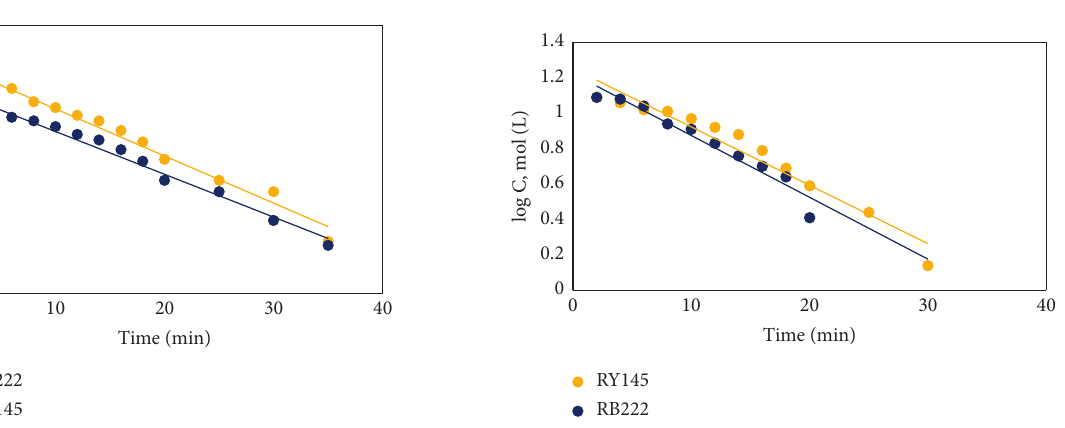
Figure 16: First-order kinetic for extraction of RY145 and RB222 dyes at concentration 6 × 10 − 5 mol/10 ml by SDS surfactant con- centration 9 × 10 − 2 mol/10